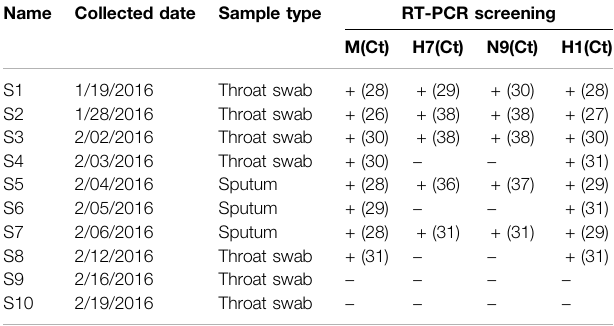
TABLE 2 | The sampling information and RT-PCR screening of H1N1 and H7N9. Name Collected date Sample type RT-PCR